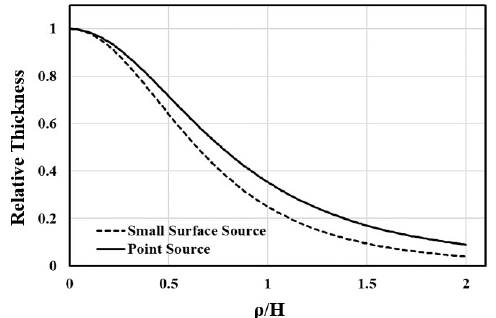
Figure 7. Distribution of the thin film thickness on the flat plate substrate holder in relation to